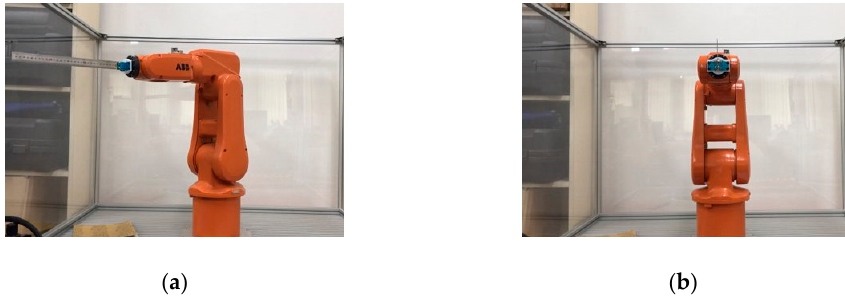
Figure 9. The experiment in which the robot moved with a constant configuration: ( a ) initial position; ( b ) final position.